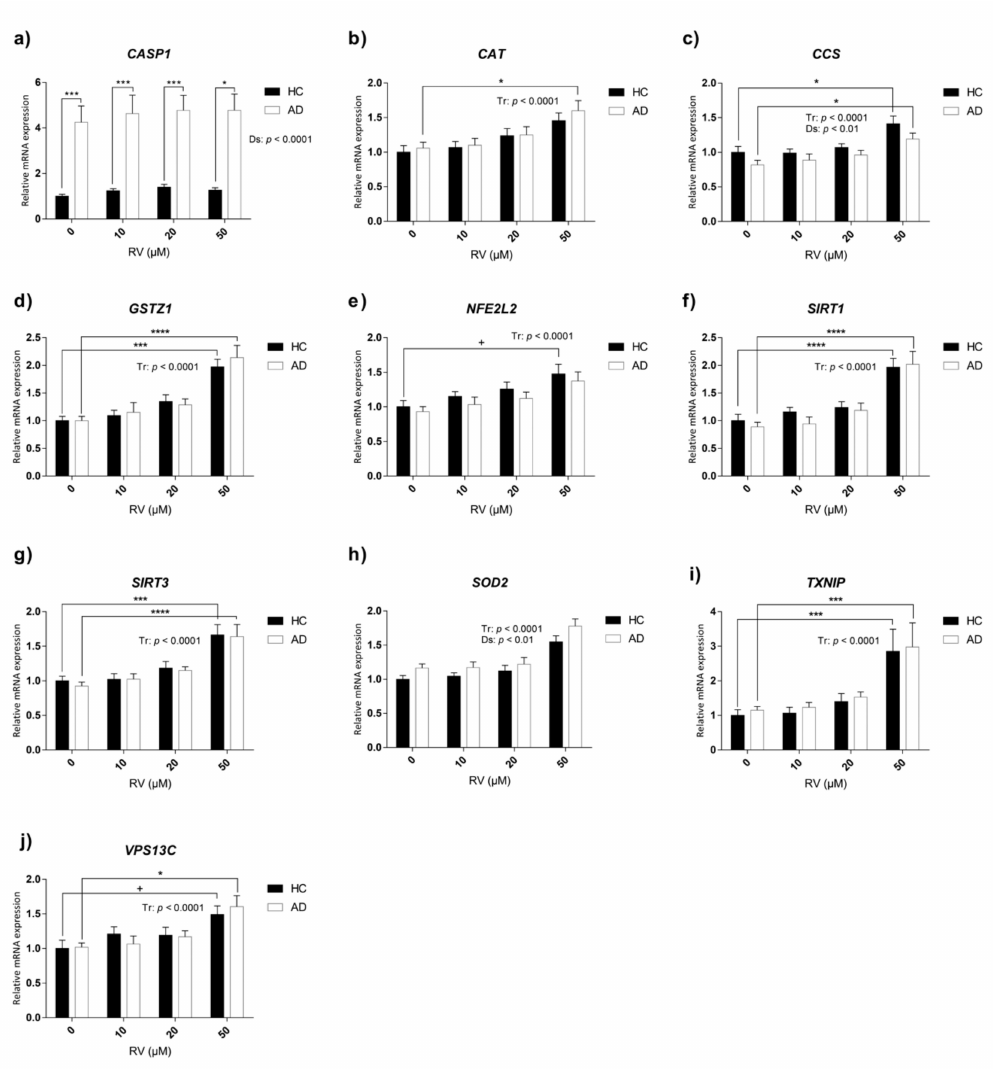
Figure 5. Relative expression of candidate genes involved in oxidative stress and aging in AD and HC lymphoblast cell lines treated with di ff erent concentrations of resveratrol (RV). Gene expression analysis by real-time PCR from lymphoblast mRNA using TaqMan FAM-labeled specific probes and normalized with the mean of both housekeeping genes: phosphoglycerate kinase 1 ( PGK1 ) and beta-2-microglobulin ( B2M ). ( a ) Caspase 1 ( CASP1 ); ( b ) catalase ( CAT ); ( c ) copper chaperone for SOD1 ( CCS ); ( d ) glutathione S-transferase zeta 1 ( GSTZ1 ); ( e ) nuclear factor (erythroid-derived 2)-like 2 ( NFE2L2 ); ( f ) sirtuin 1 ( SIRT1 ); ( g ) sirtuin 3 ( SIRT3 ); ( h ) superoxide dismutase 2 ( SOD2 ); ( i ) thioredoxin-interacting protein ( TXNIP ); ( j ) vacuolar protein sorting 13 homolog C ( VPS13C ). P -values for two-way ANOVA analysis are indicated at the top or on the right. Tr: treatment e ff ect; Ds: disease e ff ect. P -values for Tukey’s post hoc tests are indicated as: + p < 0.1, * p < 0.05, *** p < 0.001, **** p < 0.0001. Values are mean ± SEM of seven to thirteen independent experiments with n = 2 / experiment on two di ff erent cell lines per